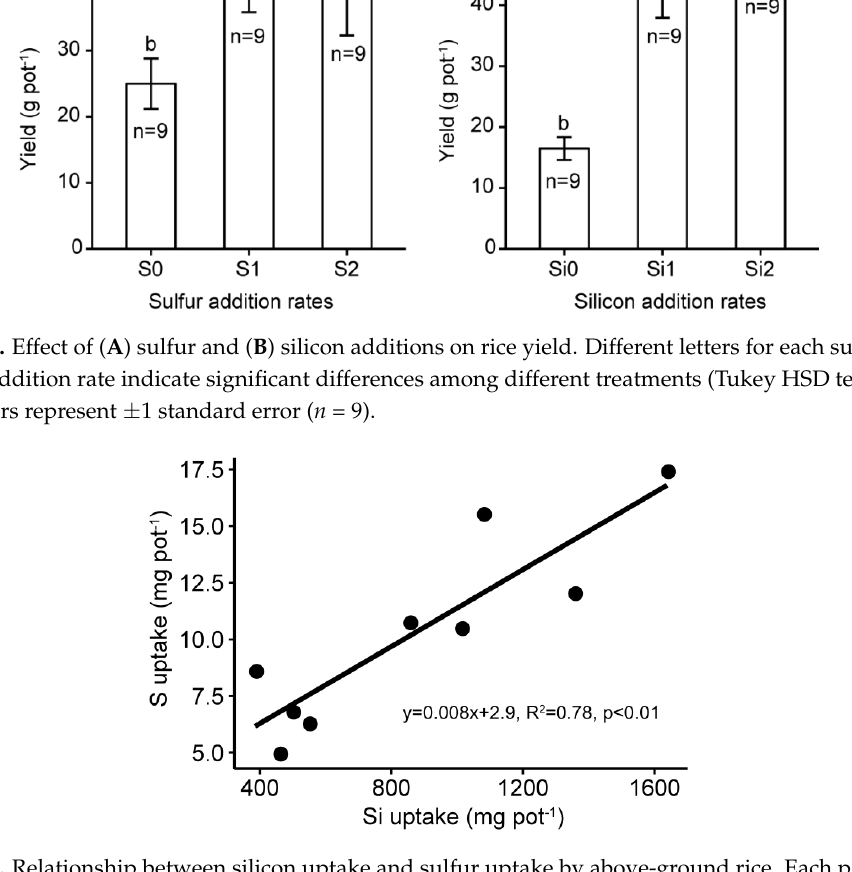
Figure 2. Relationship between silicon uptake and sulfur uptake by above-ground rice. Each point in the graph was the mean value of three replicates.